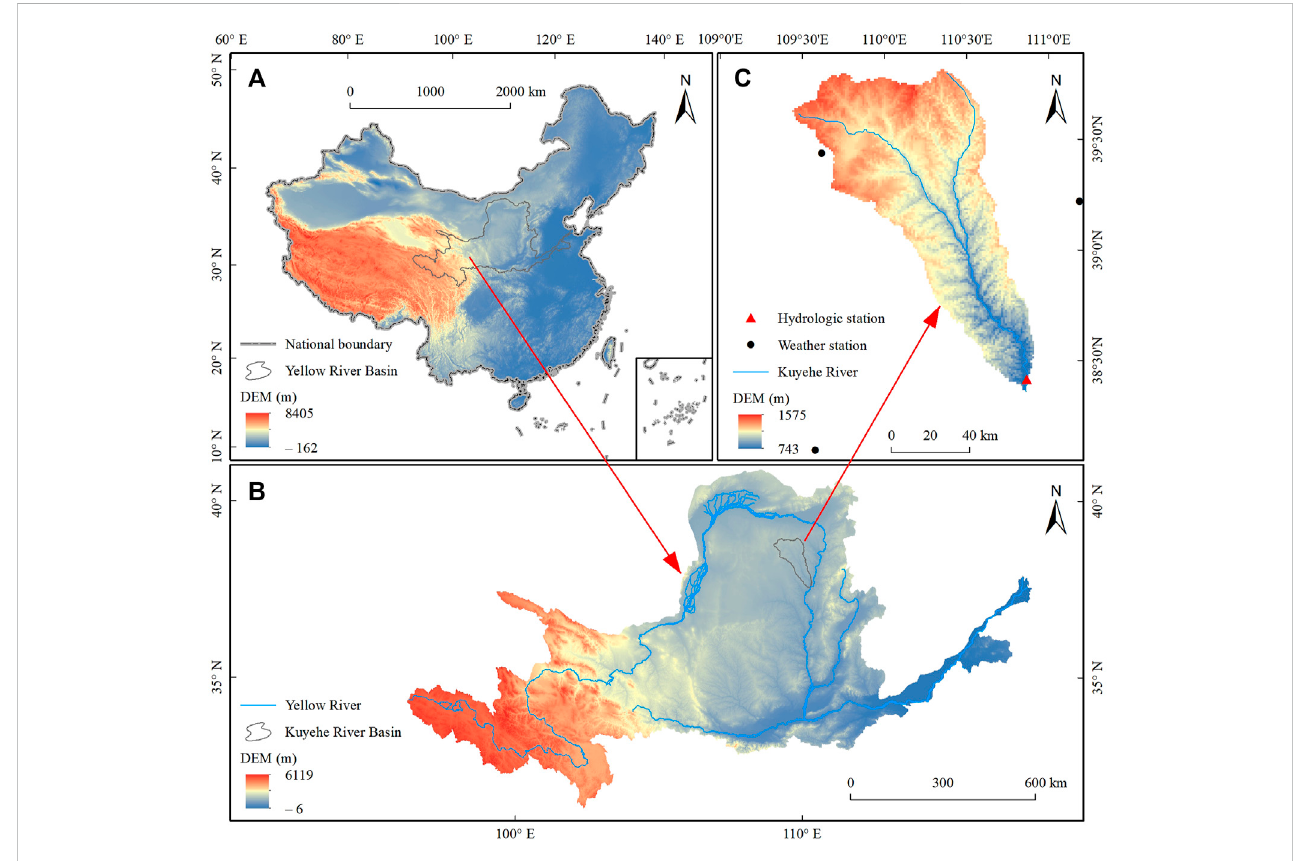
FIGURE 1 Location of the KRB in the Loess Plateau of China. (A) China, (B) The Loess Plateau, (C) The Kuye River